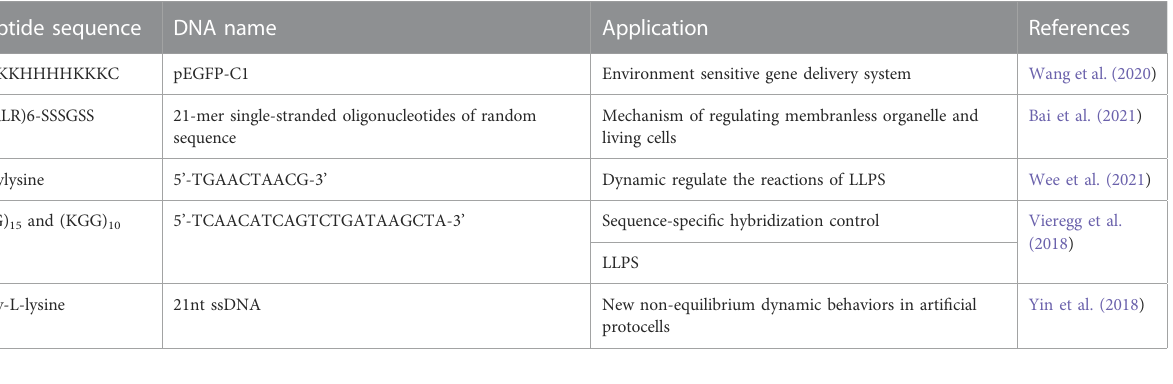
TABLE 3 Summary of peptide-DNA coacervates.